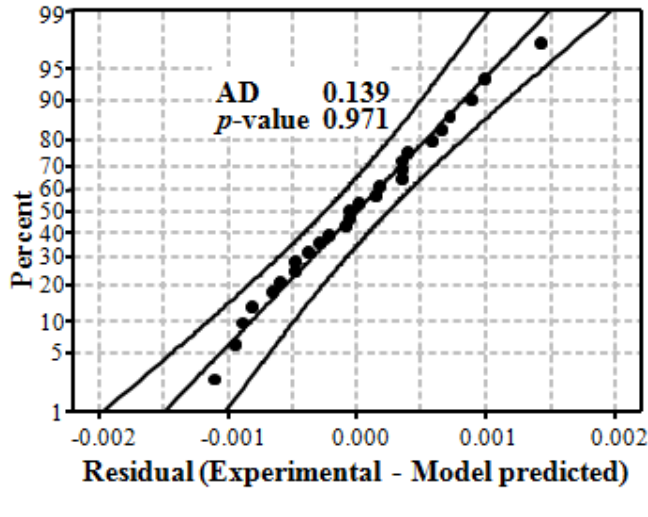
Figure 9. Anderson–Darling (AD) normality plot of the